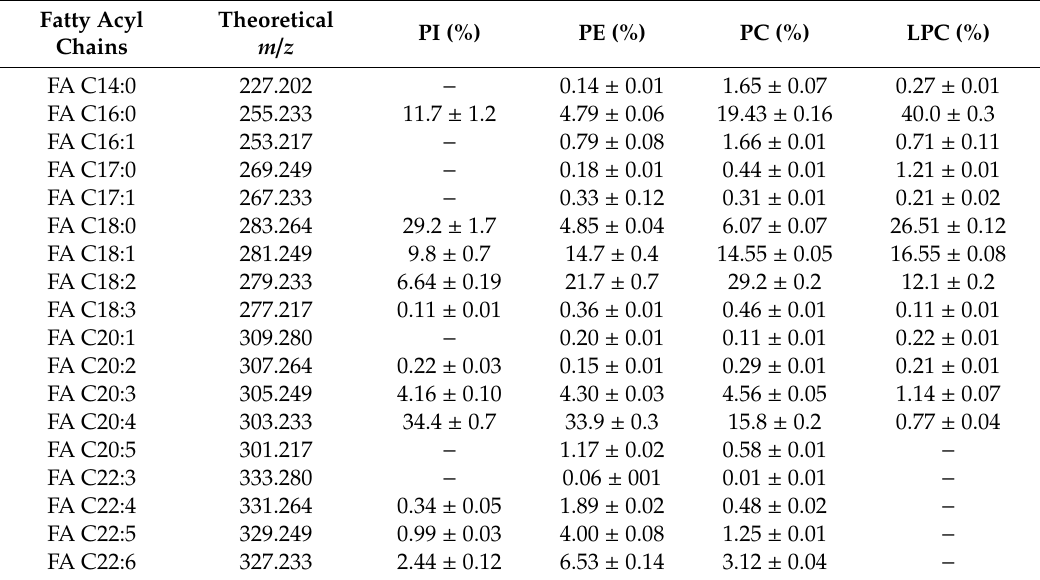
Table 2. Summary of fatty acyl chains identified in the most abundant PL occurring in an extract of healthy human plasma. The FA content for each PL class, as estimated from signals detected in AIF MS spectra, is reported in relative terms (%). Mean values ± standard deviations obtained from three replicates are